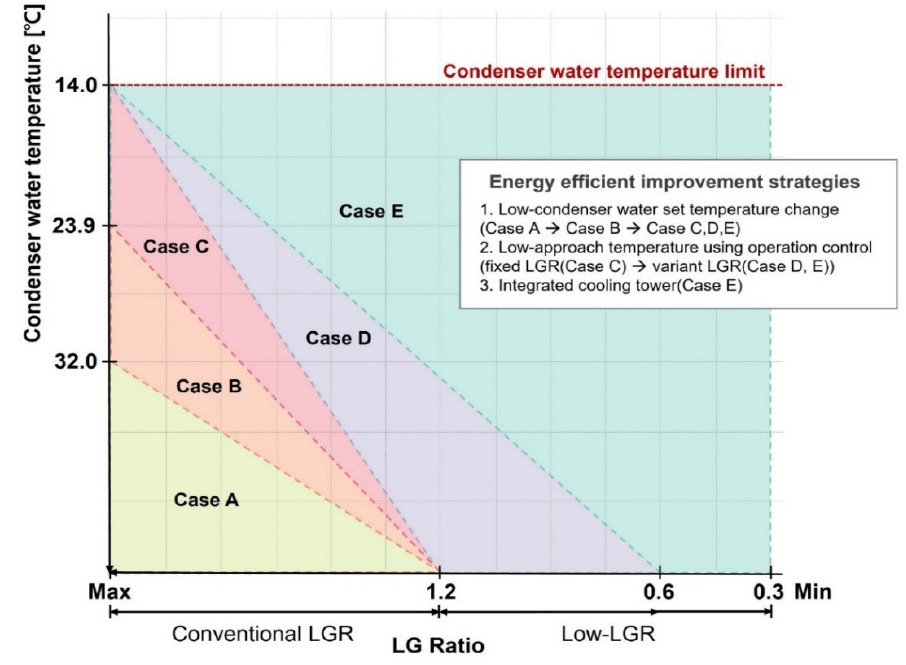
Figure 4. The diagram of the whole energy efficiency improvement strategy.